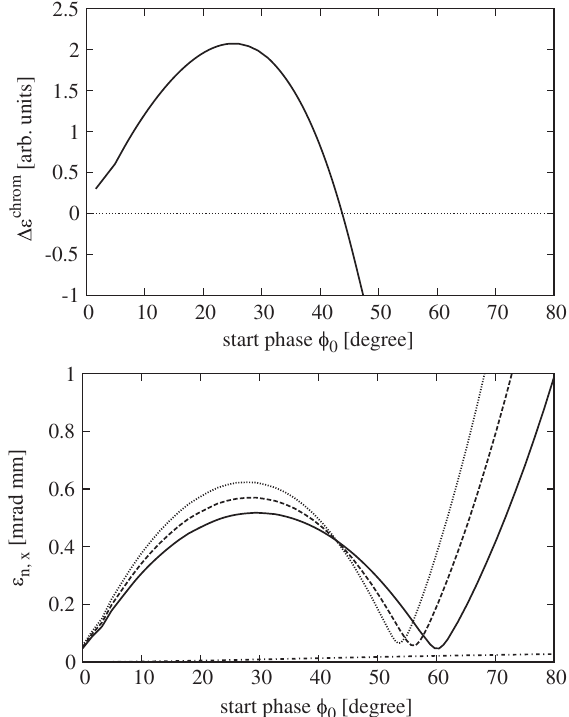
FIG. 14. Chromatic emittance variation (top) and development of the emittance in a drift (bottom) for a half-cell cavity operated ¼ 0 . 0 mm, σ ¼ 0 . 75 mm. An at 1.3 GHz, E 0 ¼ 50 MV = m, x x off initial constant current bunch of ϕ m ¼ 4 . 68 ° length has been used in the numerical simulation. The bottom plot shows the emittance at the cavity exit (solid line), after 5 cm drift (dashed line), and after 10 cm drift (dotted line). The dashed-dotted line (close to the horizontal axis) shows the analytical emittance contribution from the quadratic term in the bunch length as given by Eq.